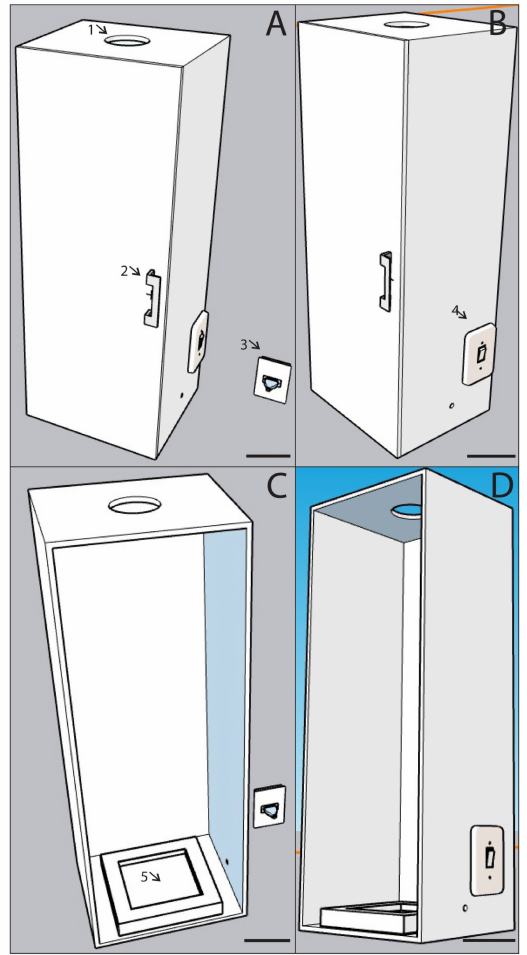
Figure 2. Technical drawing of the transilluminator for the colorimetric resazurin-based digital- imaging assay (COL-assay) developed for capturing fungal respiration activity from mycelial growth on microplates. ( A ) Closed door view. 1: camera top hole. 2: door handle. 3: power plug. ( B ) Side view. 4: light switch. ( C ) Inside view. 5: square led lamp. ( D ) Side with door